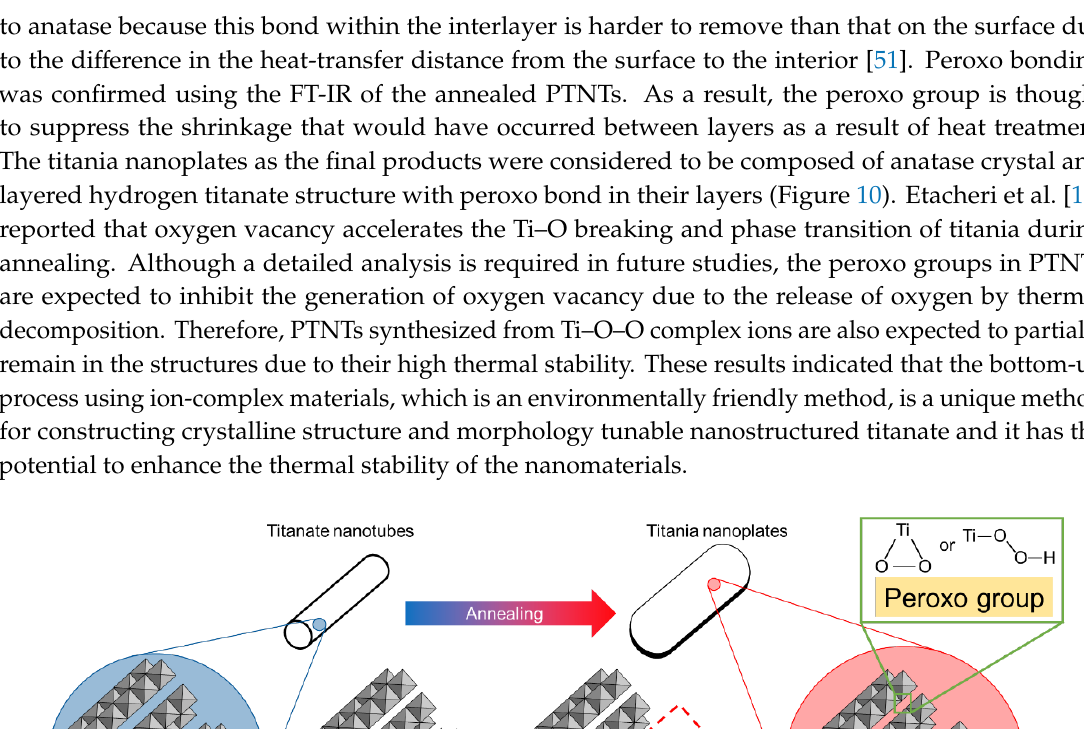
Figure 9. Hypothetical schematic view of a hydrogen titanate crystal.